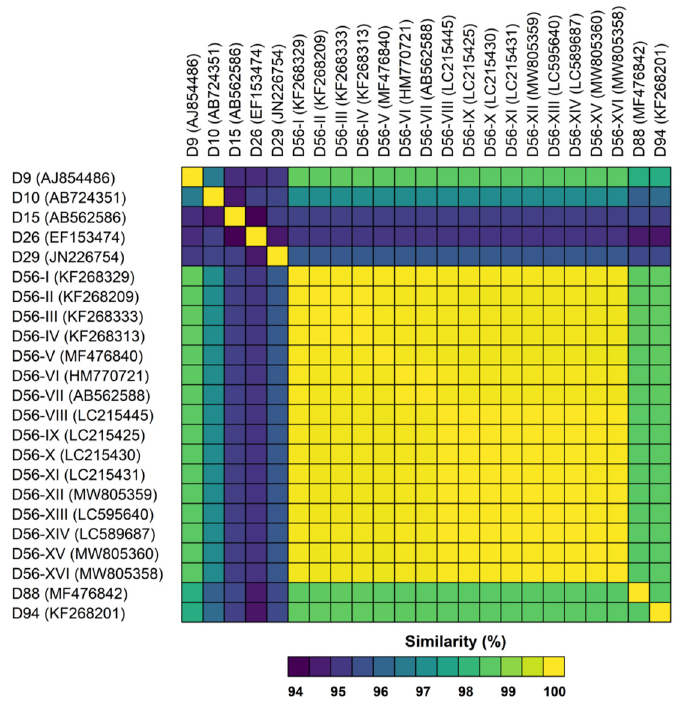
Figure 2. Pairwise analysis of whole genome sequence similarity among genotypes D9, D10, D15, D26, D29, D88, D94, and various strains of the genotype D56. The data matrix is presented as a heat map where the percentage of pairwise sequence similarities are color-coded according to the scale at the bottom of the figure.